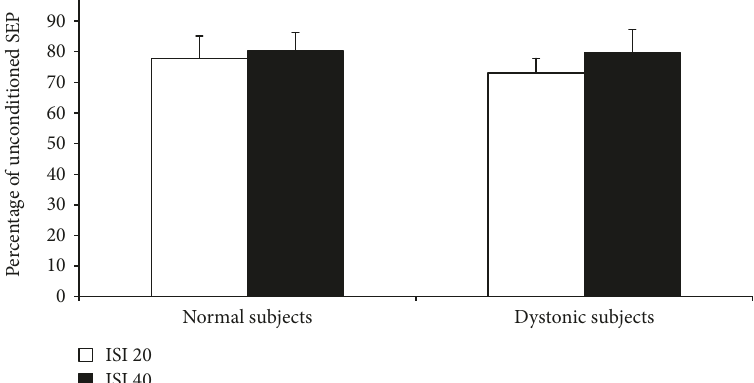
Figure 4: In normal subjects and focal dystonia patients, N20 SEP amplitudes of the S2 response were signi fi cantly suppressed at ISIs of 20 and 40ms with respect to those of the S1 control response. The (S2/S1) ∗ 100 ratio of all central SEPs did not di ff er between patients and controls at the ISI of 20 and 40ms (unpaired Mann Whitney U test: ISI 20ms: Z = − 0 4 , P = 0 62 ; ISI 40ms: Z = − 0 9 , P = 0 32 ).